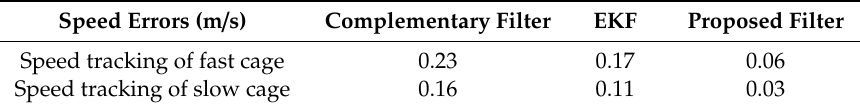
Table 4. RMS errors of di ff erent methods (speed).